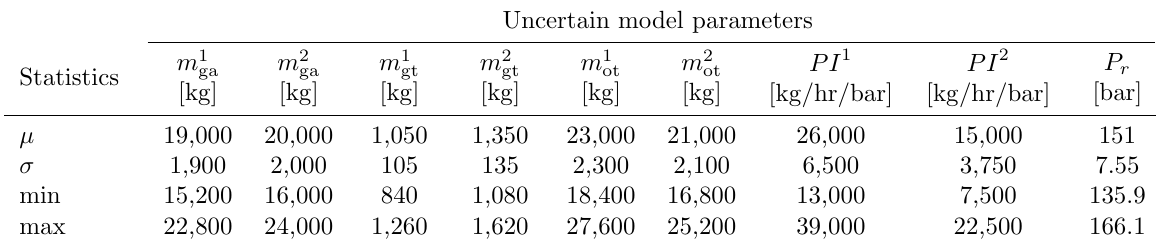
Table 1: Prior uncertainty description.